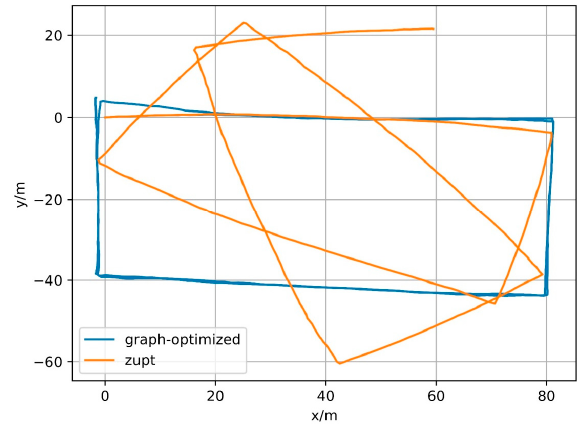
Figure 21. Results of Path B.